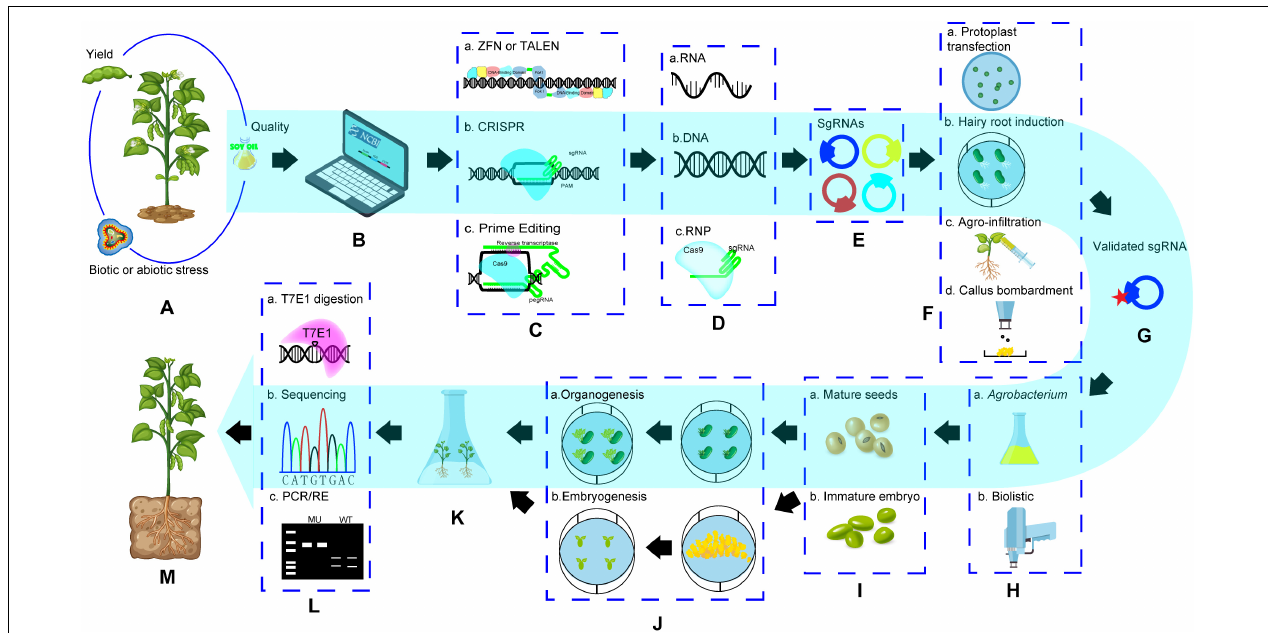
FIGURE 2 | General procedure of soybean genome editing. (A) . Target trait selection; (B) . Search for bioinformation of genetic background of target traits and find out target genes for editing; (C) . Select a GE technology; (D) . Determine editing reagent form; (E) . Design and construct editing reagents; (F). Validate activity of putative GE reagents; (G) . a selected active editing reagent (construct) for GE; (H) . select a method for editing reagent delivery; (I) . Selecta explant; (J) . Go through a regeneration procedure based on regeneration pathway; ( K ). Regenerated plants from explants transformed with editing reagents; (L) . Screening target gene edited events using molecular methods; (M) . A genome edited whole soybean plant. (1) Items in dotted box are the choice of technology platforms, method or explants. (2) Pathway in blue showed a GE procedure based on CRISPR system with DNA editing reagents and Agrobacterium -mediated delivery